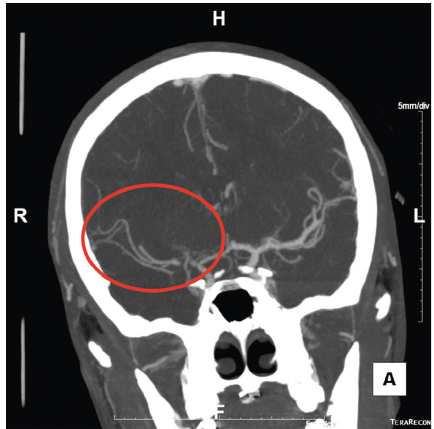
Figure 4: Postthrombectomy, CTA maximum intensity projection (MIP) shows improved blood flow and distal filling of the right